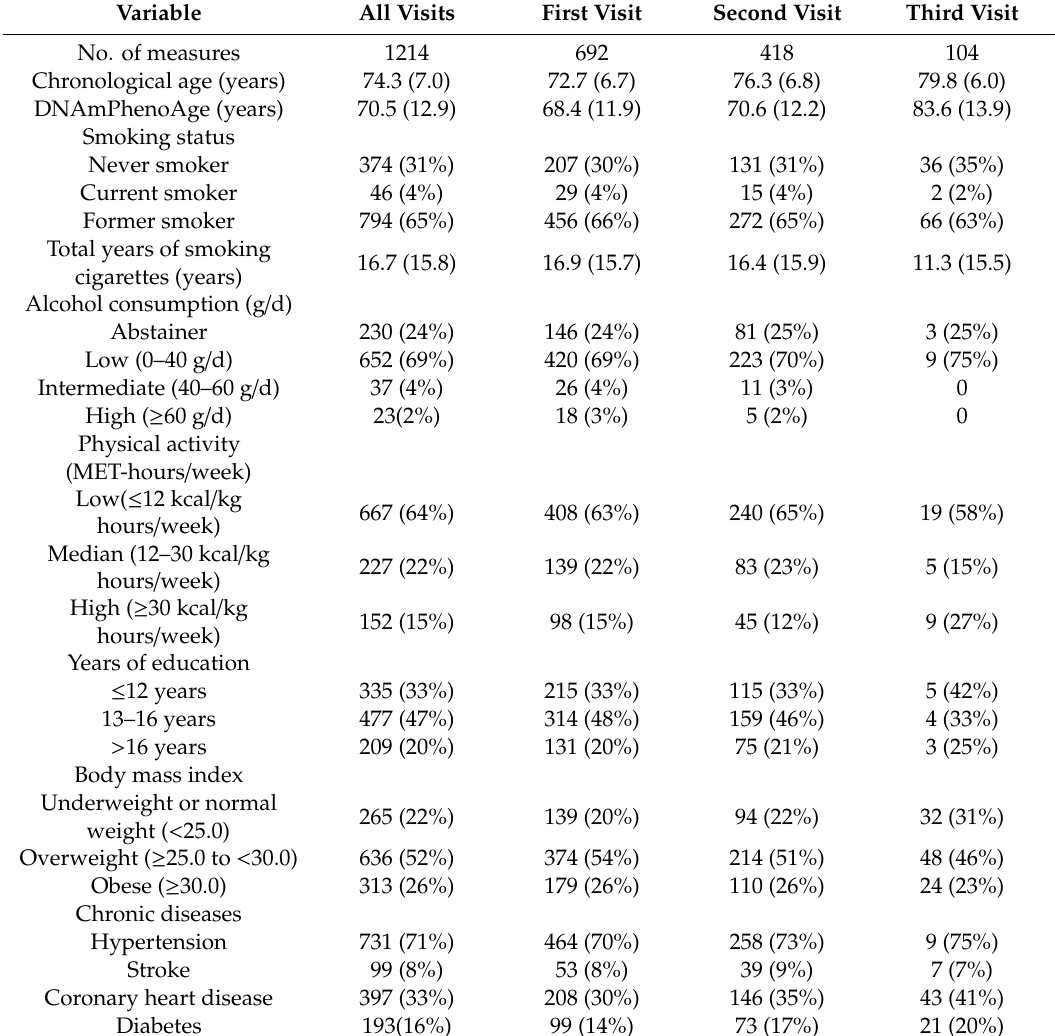
Table 1. Population characteristics of participants in the Veterans A ff airs Normative Aging Study in Boston, MA, 1999–2013 a .